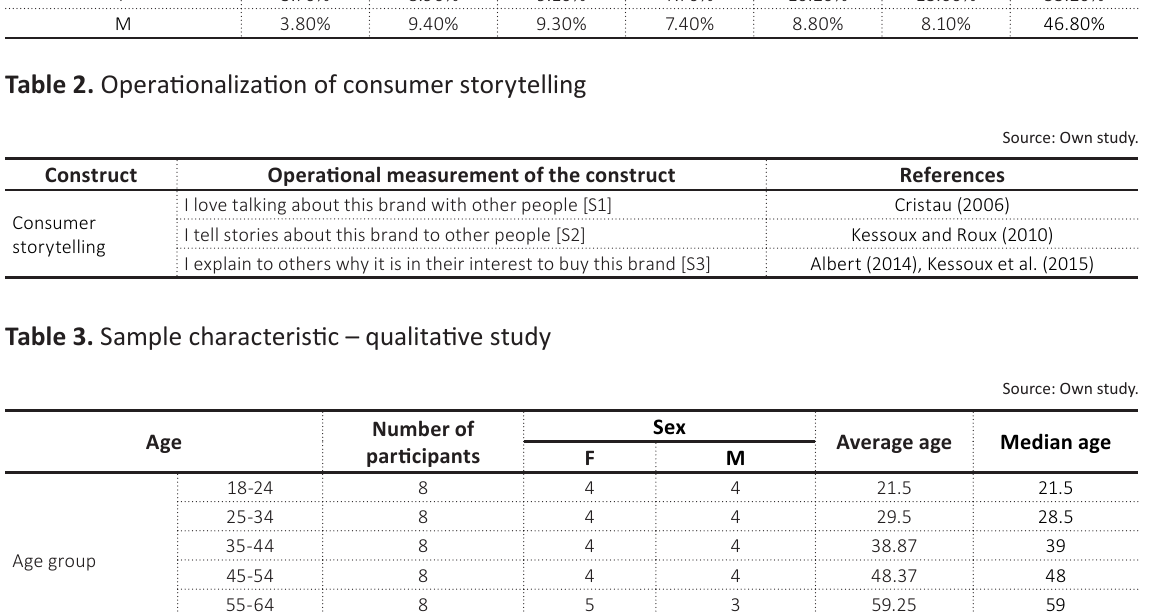
Source: Own study.